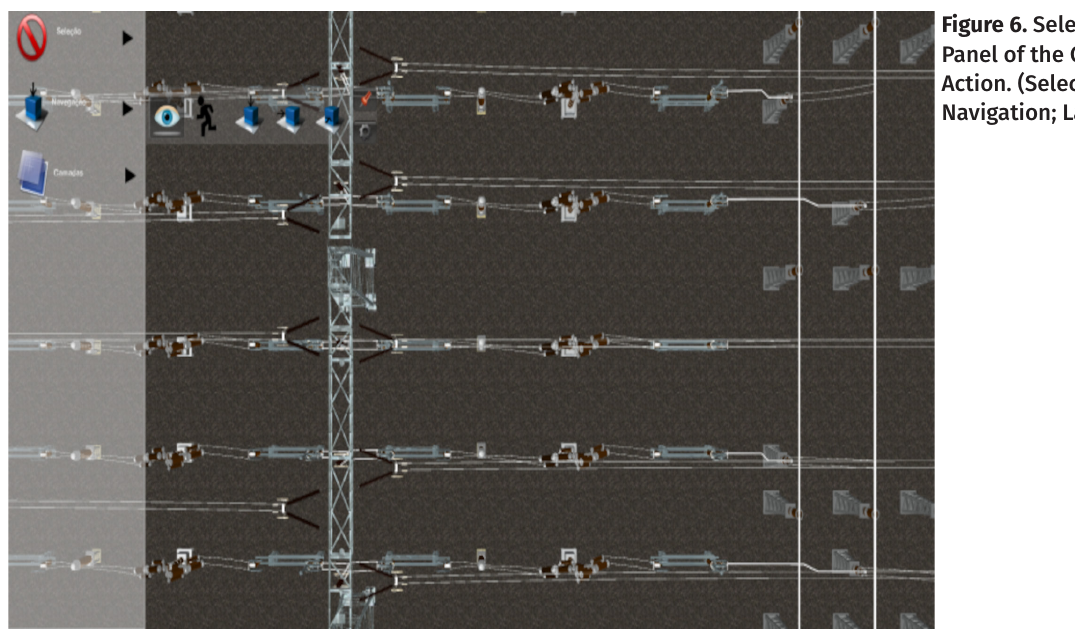
Figure 6. Selection Panel of the Control Action. (Selection; Navigation;